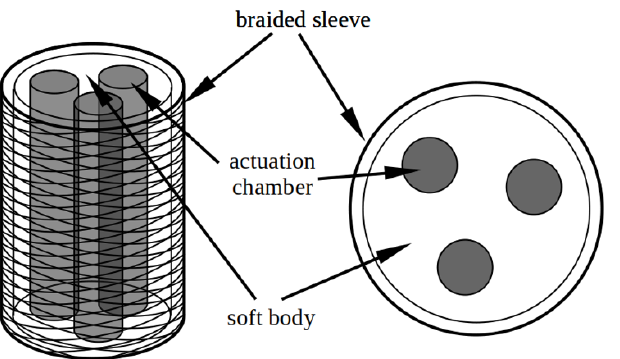
Figure 6. Solution for the ballooning issue: a braided sleeve allowing for bending and elongation but